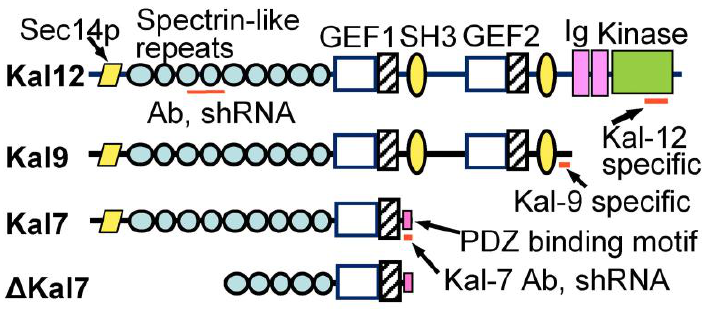
FIGURE 1. Alternative splicing generates different isoforms of Kalirin. The largest Kalirin isoform, Kal12, contains one Sec14p domain, nine spectrin-like repeats, two Rho GEF domains, two SH3 domains, two IgFn domains, and one serine/threonine kinase domain. Kal7 contains a unique PDZ binding